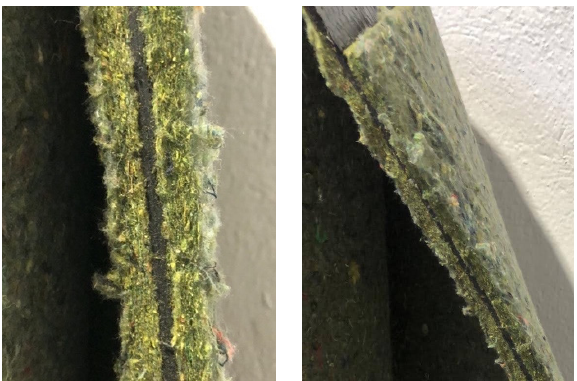
Figure 4. Details of the viscoelastic multilayer.